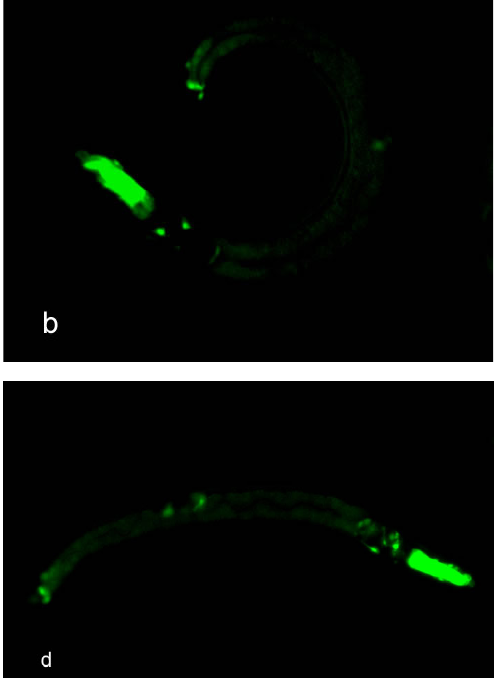
Figure 4. Representative images of CF1553 worms 24 hours after the treatment with the β-aryl-chalcogenium azide compounds at concentration of 10 μM (a) Control (b) Compound S601AZ (c) Compound S602AZ (d) Compound S603AZ (e) Compound S604AZ. Data represent the mean ± SEM of three to four